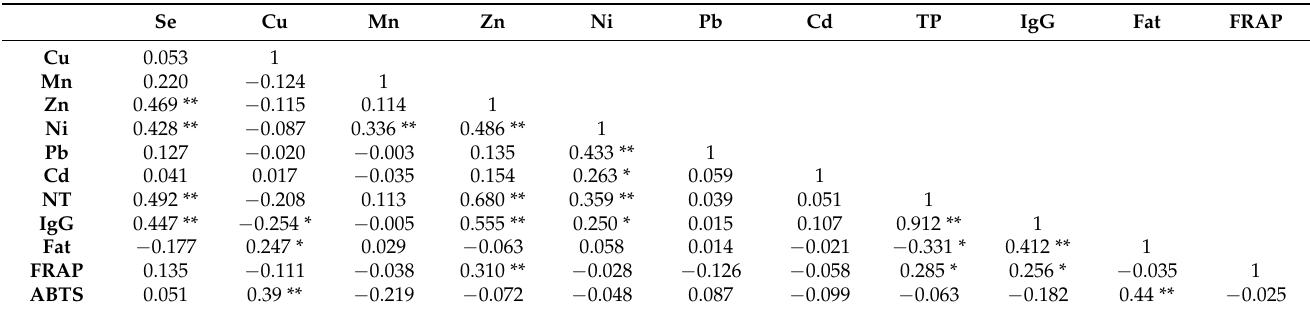
Table 3. Correlation matrix between trace minerals and immunoglobulins, protein and fat content, and antioxidant power of